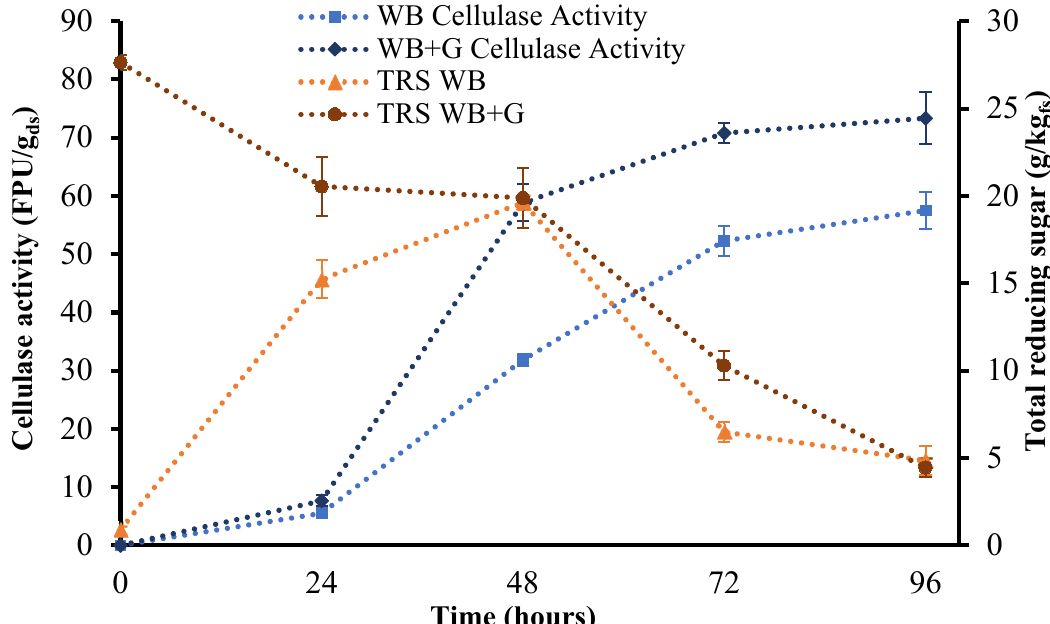
Figure 2. Cellulase activity and total reducing sugar (TRS) for wheat bran fermented by A. awamori during 96 h. Square and rhombus represent cellulase activity (FPU/g ds ); ∙∙ ■ ∙∙ WB shows wheat bran substrate with sterile deionized water; ∙∙ ♦ ∙∙ WB+G shows wheat bran substrate with the addition of glucose. Triangle and circle represent total reducing sugar; ∙∙ ▲ ∙∙ WB shows wheat bran substrate with sterile deionized water; ∙∙●∙∙ WB+G shows wheat bran substrate with the addition of glucose.